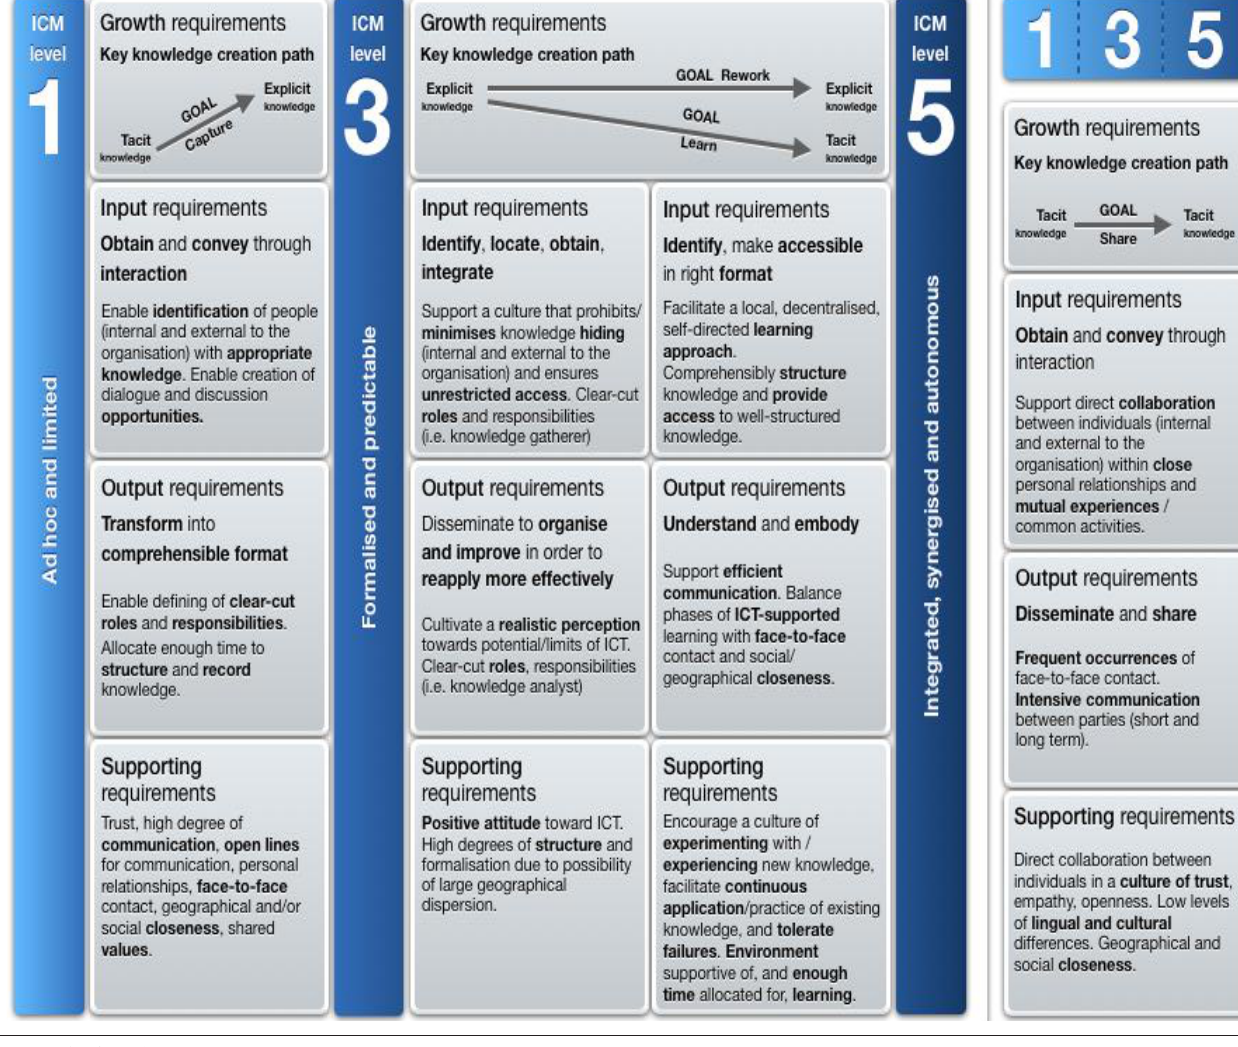
FIGURE 1: Knowledge management framework to grow innovation